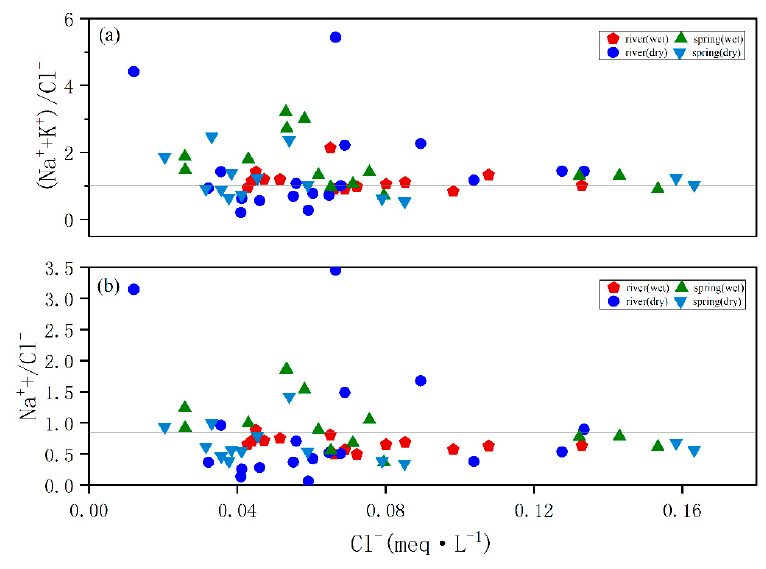
Figure 5. Ion ratio in water samples: ( a ) Na + /Cl − and ( b ) (Na + + K + )/Cl − of the river and spring waters.